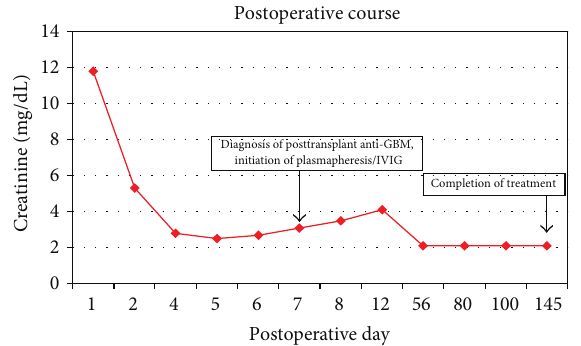
Figure 1: IVIG: intravenous immunoglobulin; GBM: glomerular basement